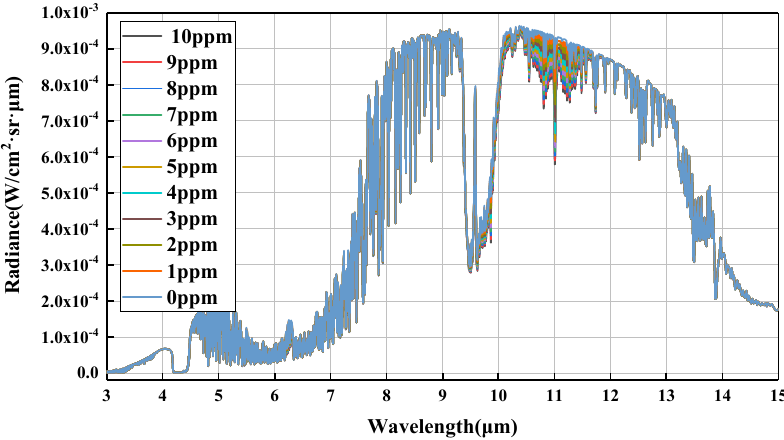
Figure 5. Simulated TOA radiance observed by detector for 1,3-butadiene.